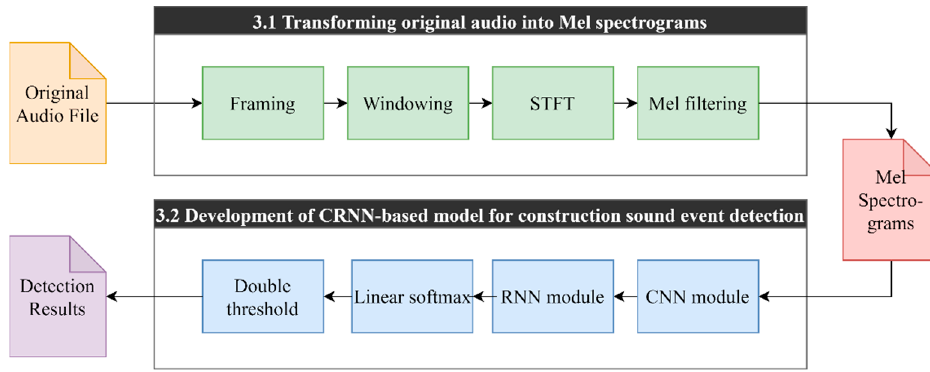
Figure 4. The processing steps from original audio to the Mel spectrogram.